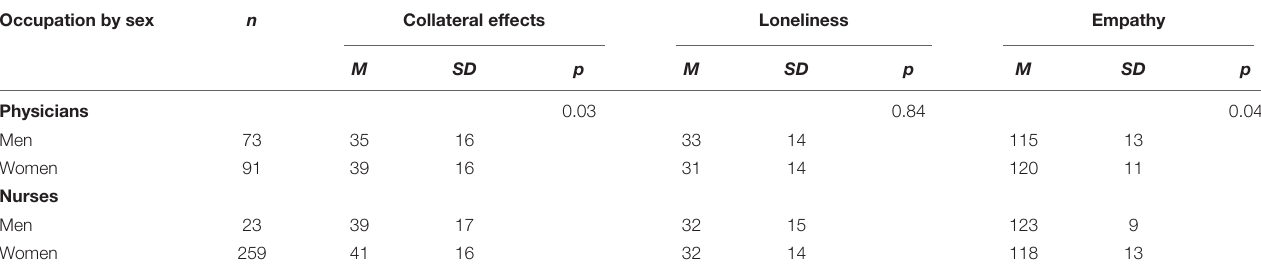
TABLE 3 | Summary result of Kruskal–Wallis test to compare “occupation by sex” groups in a sample of Spanish healthcare professionals ( N = 450). Occupation by